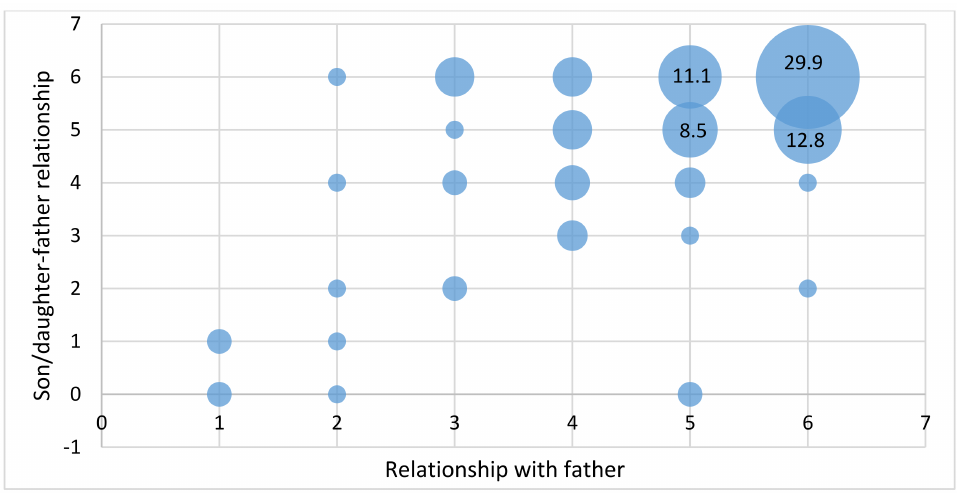
Figure 2. Assessment of father–adolescent relationship by both groups of